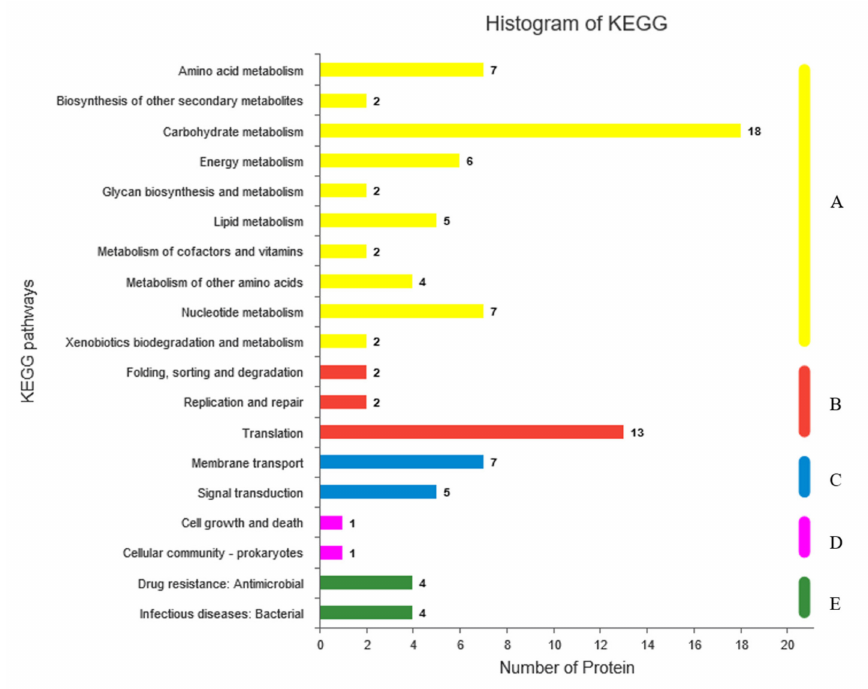
Figure 6. Kyoto Encyclopedia of Genes and Genomes (KEGG) annotation of distribution analysis of the 5 branches in the KEGG pathways including metabolism ( A ), genetic information processing ( B ), environmental information processing ( C ), cellular processes ( D ), and human diseases ( E